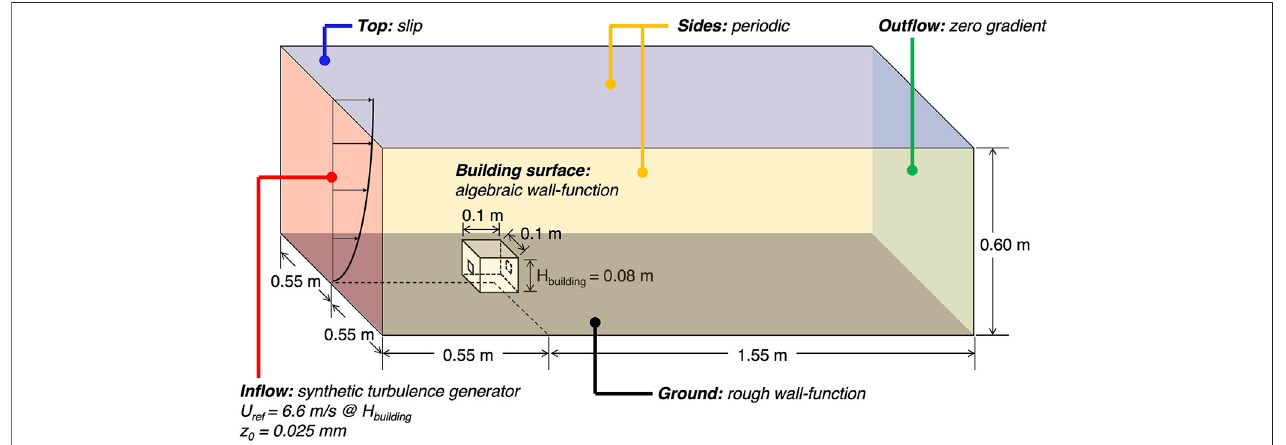
FIGURE 1 | Computational domain and boundary